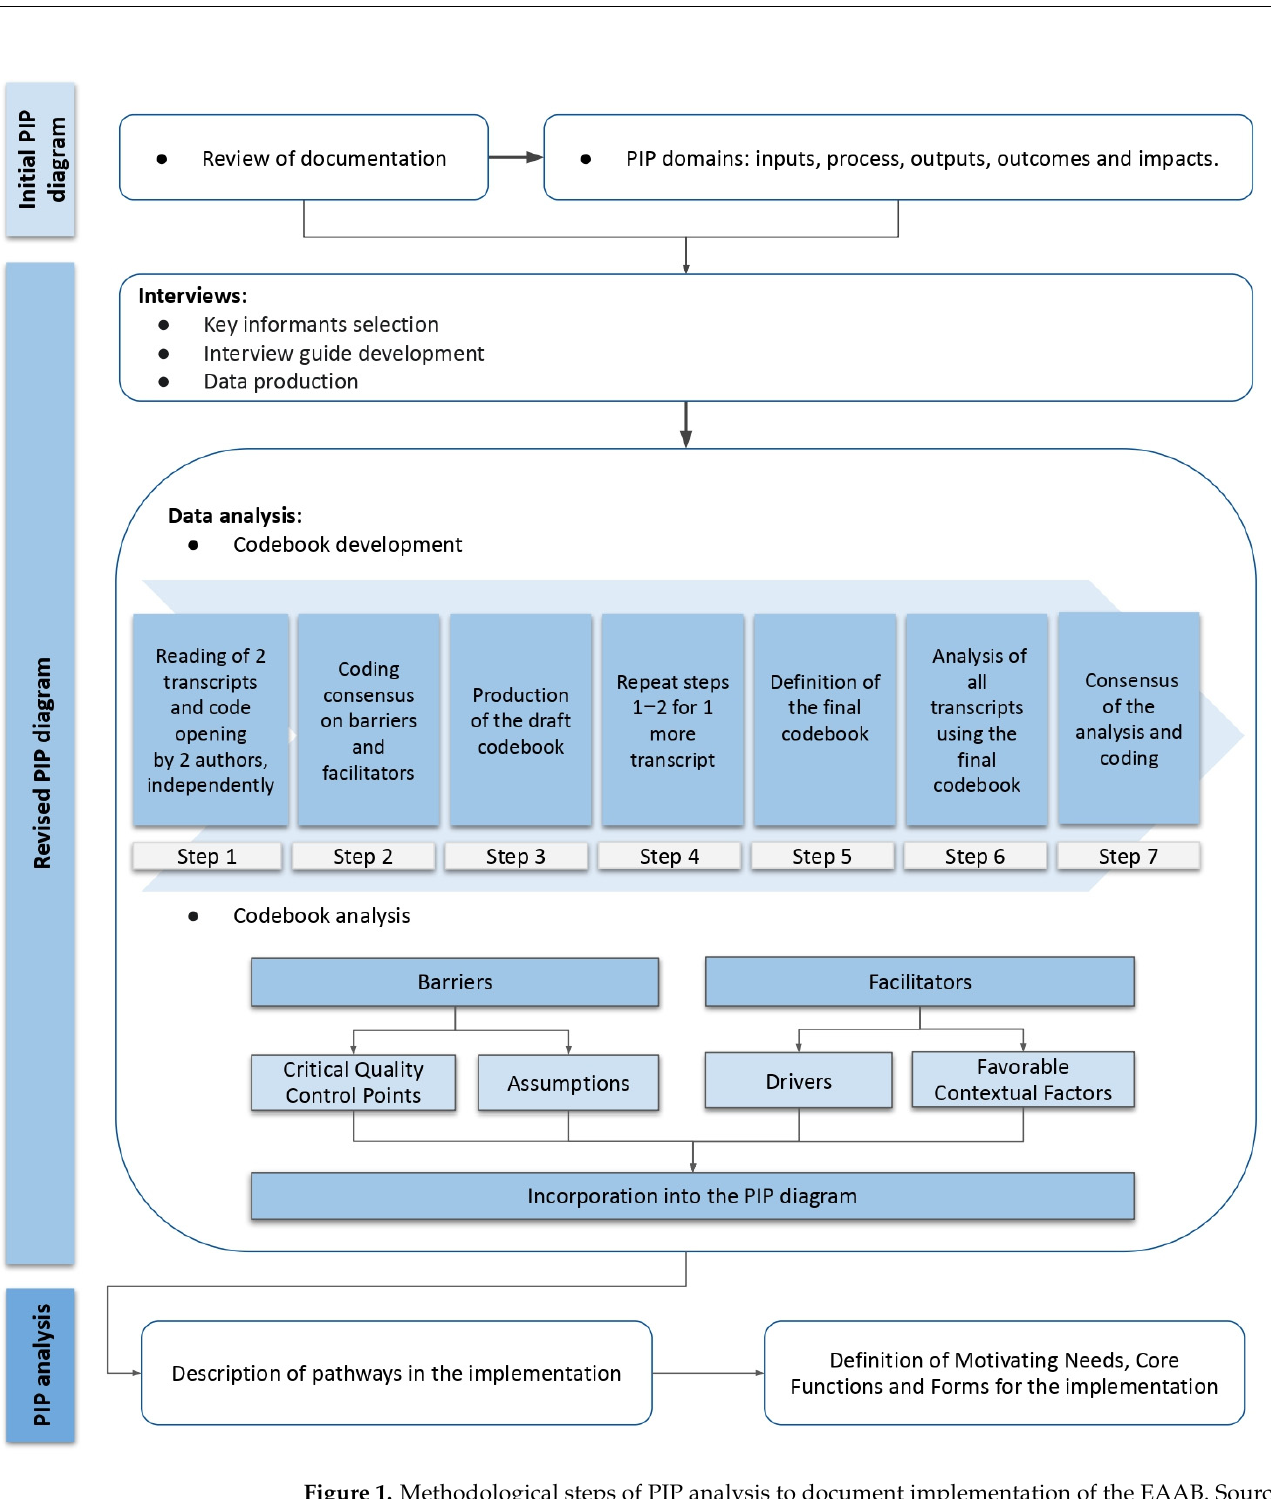
Figure 1. Methodological steps of PIP analysis to document implementation of the EAAB. Source: Developed by the authors. Notes: EAAB (Brazilian Breastfeeding and Complementary Feeding Strategy (Estratégia Amamenta e Alimenta Brasil)); PIP (Program Impact Pathway).